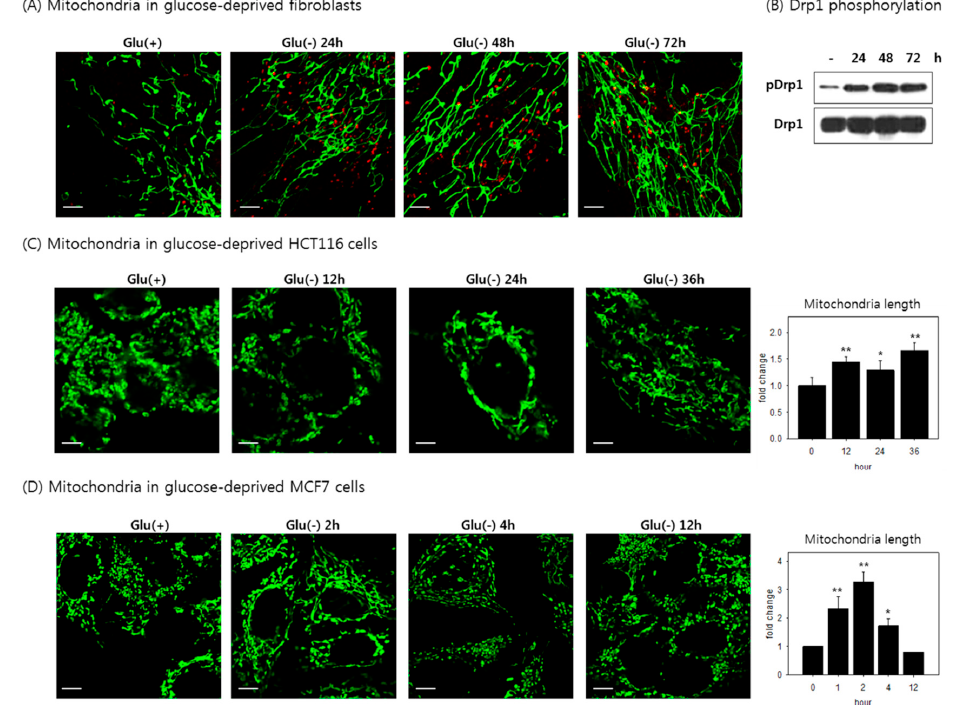
Figure 6. Elongation of mitochondria. ( A ) Fibroblasts cultured on a coverslip were deprived for the indicated time period and visualized by confocal microscopy. Mitochondria and autophagosomes were immunostained with antibodies against OXPHOS and LC3, respectively; ( B ) fibroblasts were glucose deprived for 1, 2, or 3 days, and subjected to immunoblot analysis with antibodies against Ser637 phospho-Drp1 or Drp1; ( C , D ) HCT116 or MCF7 cells were incubated in glucose-free medium for 36 h or 12 h. Mitochondria were immunostained with Tom20 antibody and observed by confocal microscopy. Lengths of mitochondria were measured and plotted by ImageJ analysis software. Lengths of mitochondria was measured in more than 20 cells and plotted by ImageJ analysis software. All scale bars in microscopy indicate 5 μ m. Values are presented as mean ± s.d.; * p < 0.05, ** p < 0.01 by ANOVA.